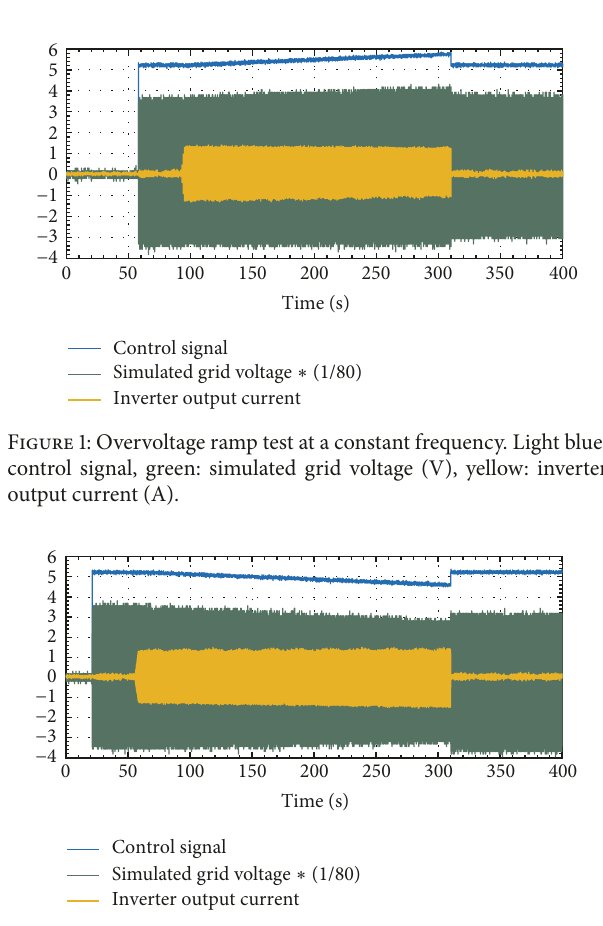
Figure 2: Undervoltage ramp test at a constant frequency. Light blue: control signal, green: simulated grid voltage (V), yellow: inverter output current (A).